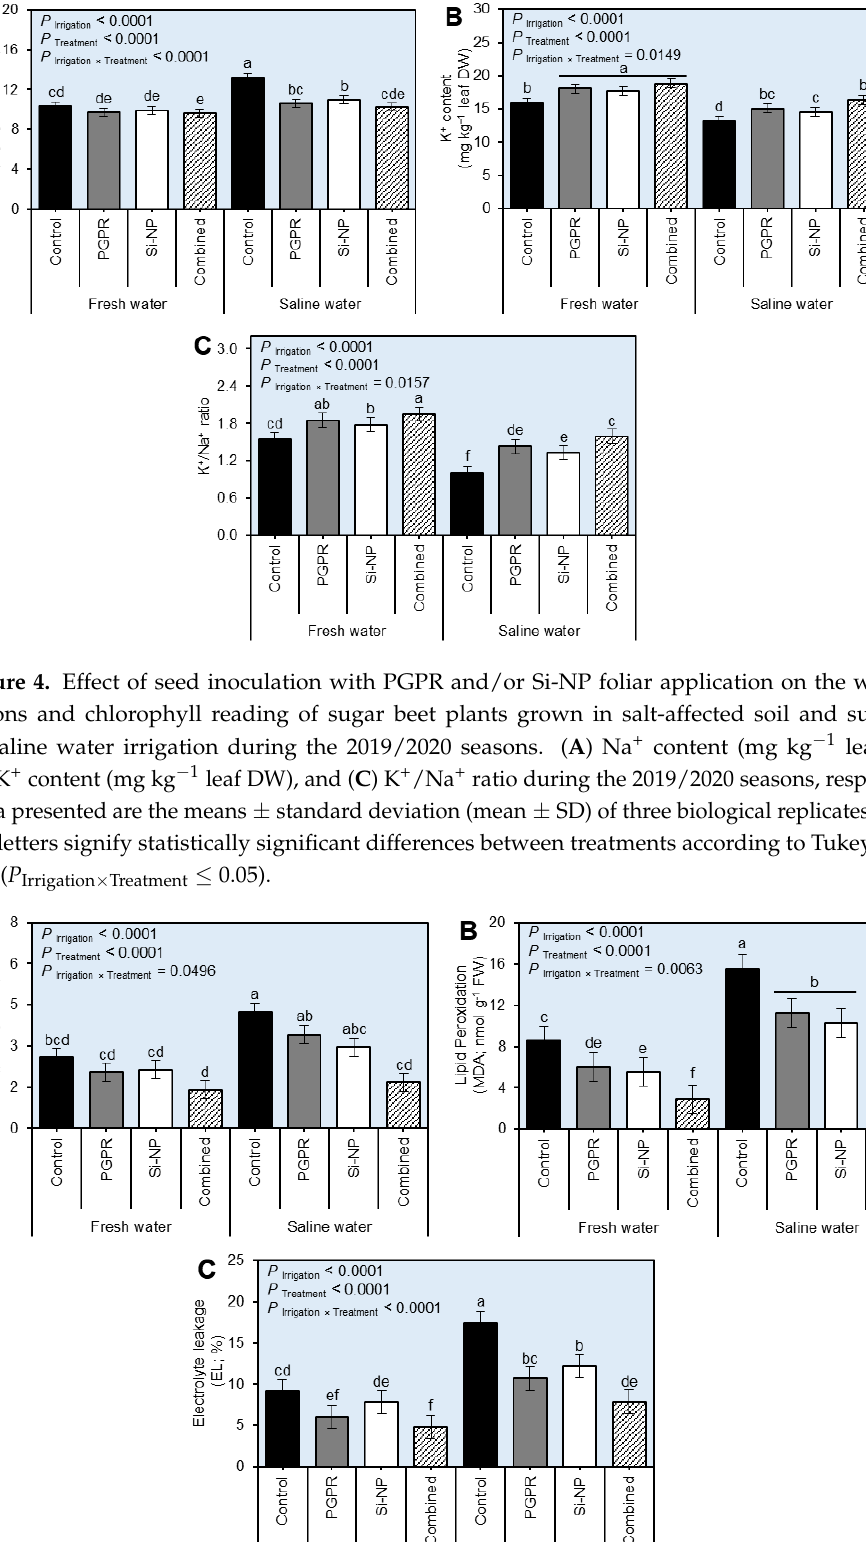
Figure 4. Effect of seed inoculation with PGPR and/or Si-NP foliar application on the water relations and chlorophyll reading of sugar beet plants grown in salt-affected soil and subjected to saline water irrigation during the 2019/2020 seasons. ( A ) Na + content (mg kg −1 leaf DW), ( B ) K + content (mg kg −1 leaf DW), and ( C ) K + /Na + ratio during the 2019/2020 seasons, respectively. Data presented are the means ± standard deviation (mean ± SD) of three biological replicates. Different letters signify sta- tistically significant differences between treatments according to Tukey’s HSD test ( P Irrigation × Treatment ≤ 0.05).